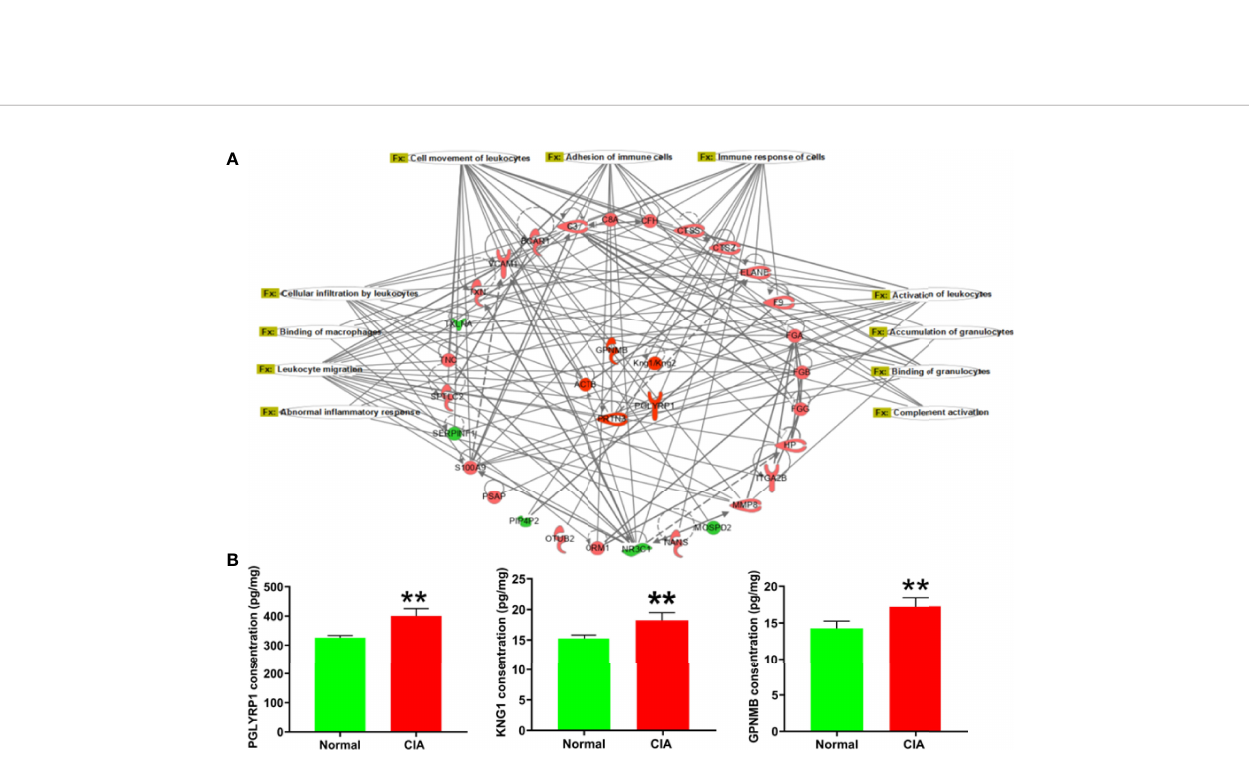
FIGURE 6 | The immune-related function network and the veri fi cation of representative DEPs in the peak phase. (A) The immune-related function network: the red color represented the upregulation of protein expression in the model group vs. the normal group and the green color represented the downregulation of protein expression in the model group vs. the normal group. (B) The veri fi cation of DEPs related to immune function. Data were mean ± SD. N = 6. ** p < 0.01 compared with the normal group.